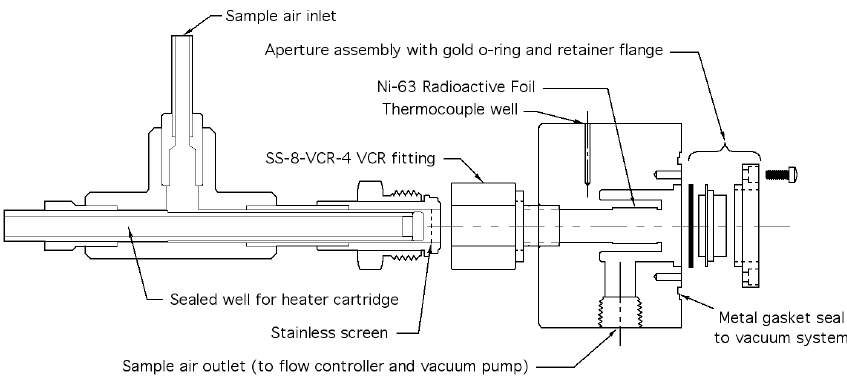
Fig. A1. High temperature inlet and atmospheric pressure ionization source. Sample air flows over a sealed stainless steel tube containing the heater cartridge, then passes to the ionization volume. The 63 Ni foil is formed into a cylinder and placed in front of the inlet aperture. The source block bolts to the decluster chamber and seals with an aluminum gasket.